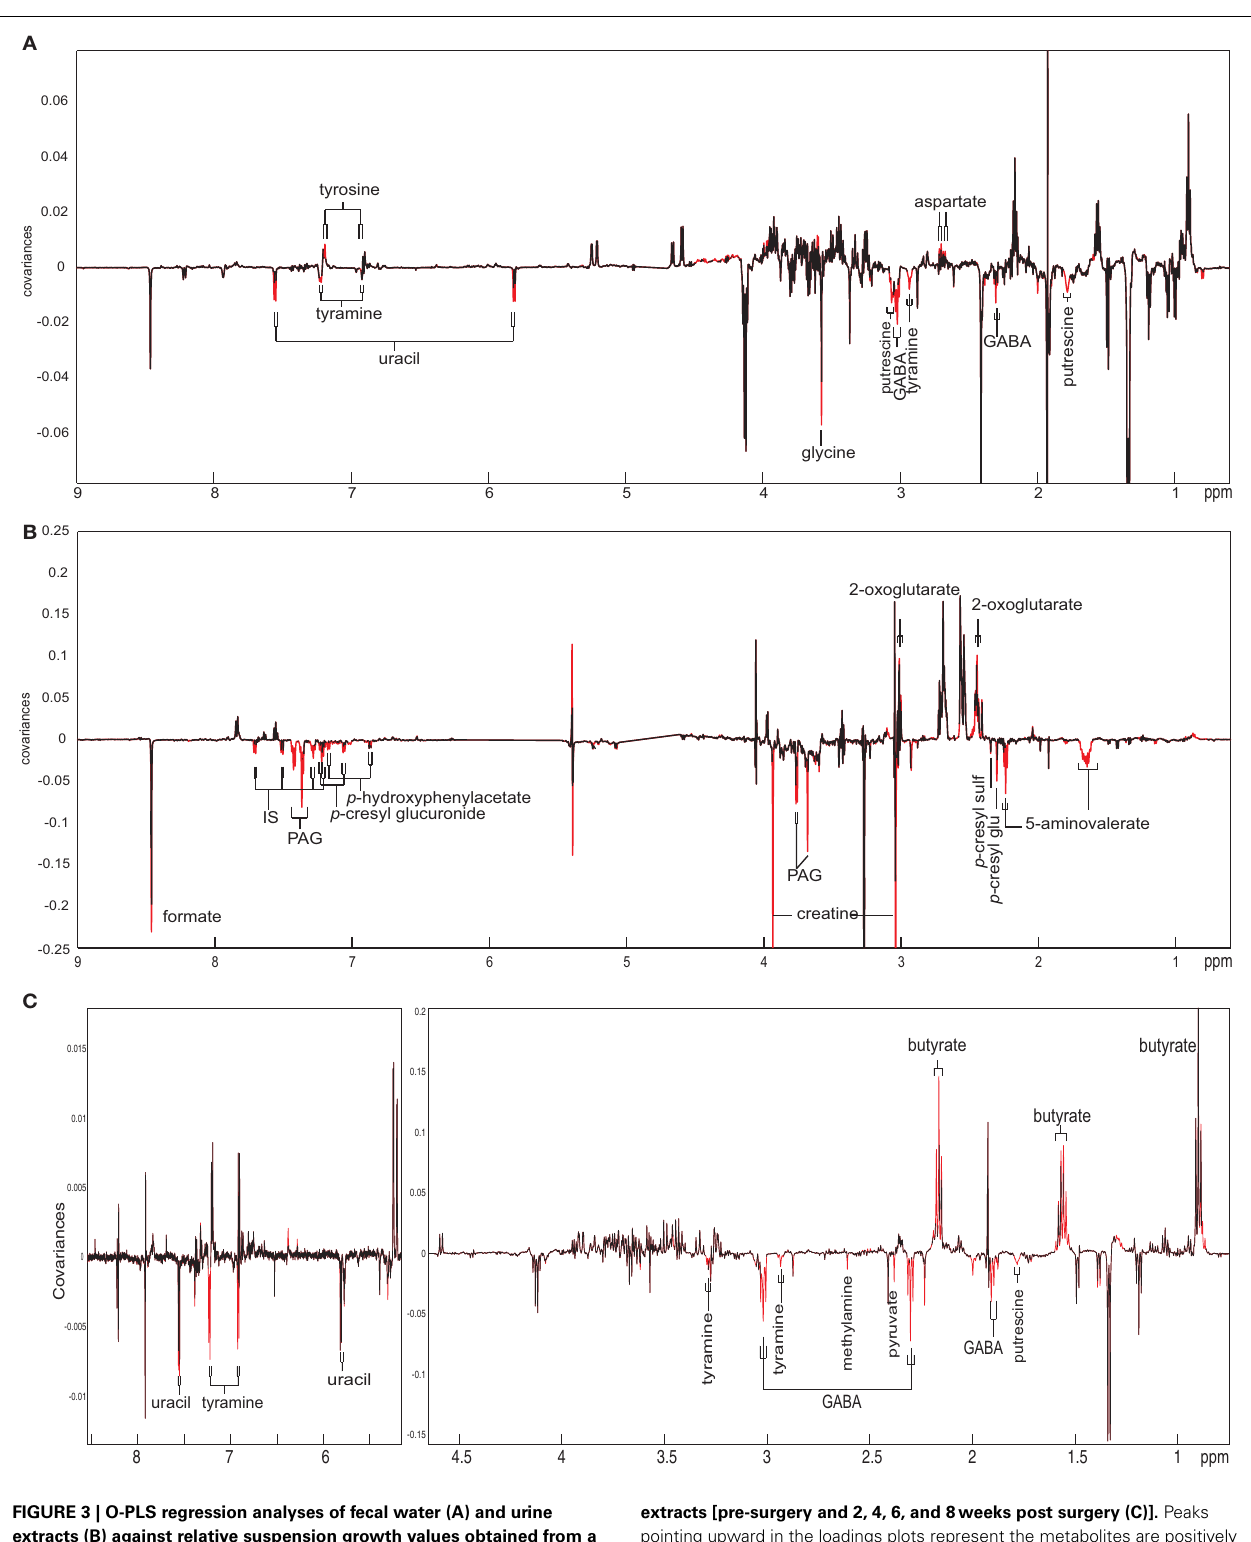
FIGURE 3 | O-PLS regression analyses of fecal water (A) and urine extracts (B) against relative suspension growth values obtained from a 24-h treatment of L5178Y cells with sham or RYGB-operated rat fecal extracts (week 2 and week 8) or O-PLS regression analyses of fecal water extracts against relative suspension growth obtained from 24h treatment of L5178Y cells with two sham or two RYGB fecal water